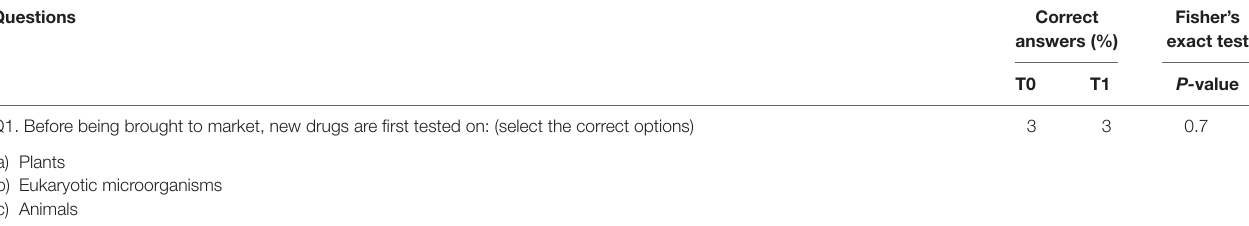
tAbLe 2 | Performance in the pre- (T0) and post-test (T1) for the test group.